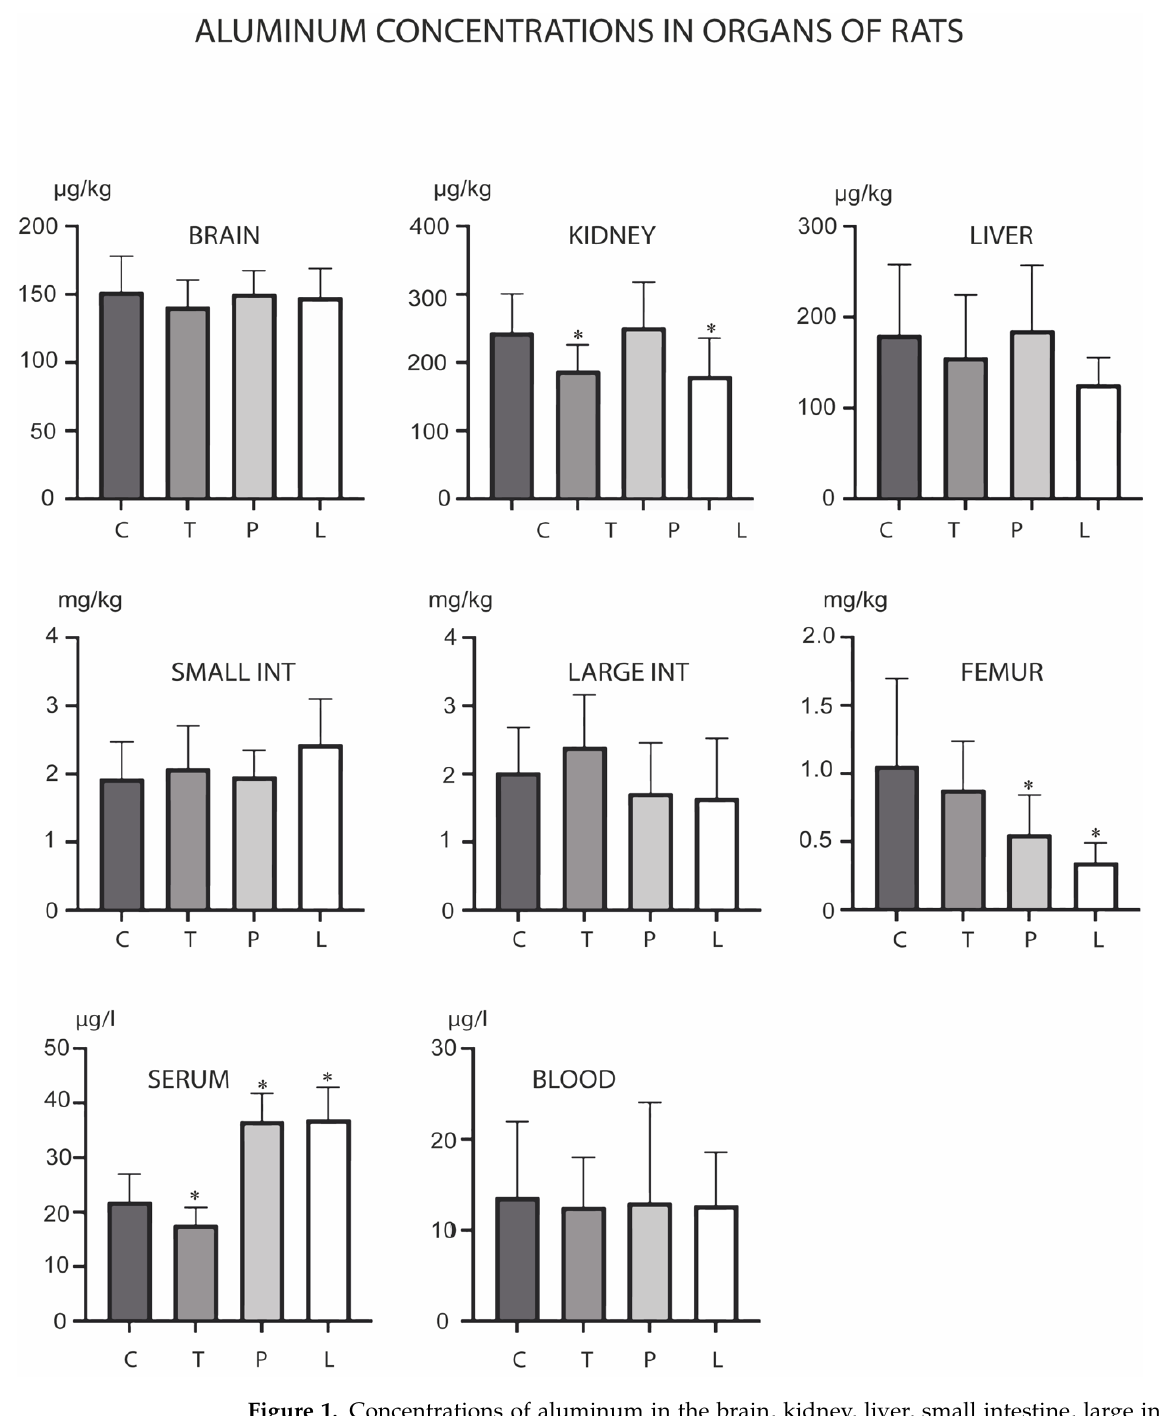
Figure 1. Concentrations of aluminum in the brain, kidney, liver, small intestine, large intestine, serum, blood and femur after the three-month oral administration of silicates. C denotes the control group; T denotes the experimental group receiving tribomechanically activated zeolite clinoptilolite (TMAZ); P denotes the experimental group receiving the double tribomechanically activated zeolite clinoptilolite (PMA zeolite); and L denotes the experimental group receiving Ludox silica. Asterisk (*) denotes significant differences between the experimental groups, with control at p < 0.05. As levels changed in the small intestine and serum (Figure 2). TMAZ reduced the level of this metal in the small intestine, while both PMA zeolite and Ludox increased its levels in serum. Overall, Cd levels were reduced in the presented experiment (Figure 3). PMA zeolite reduced its levels in the small intestine and serum.